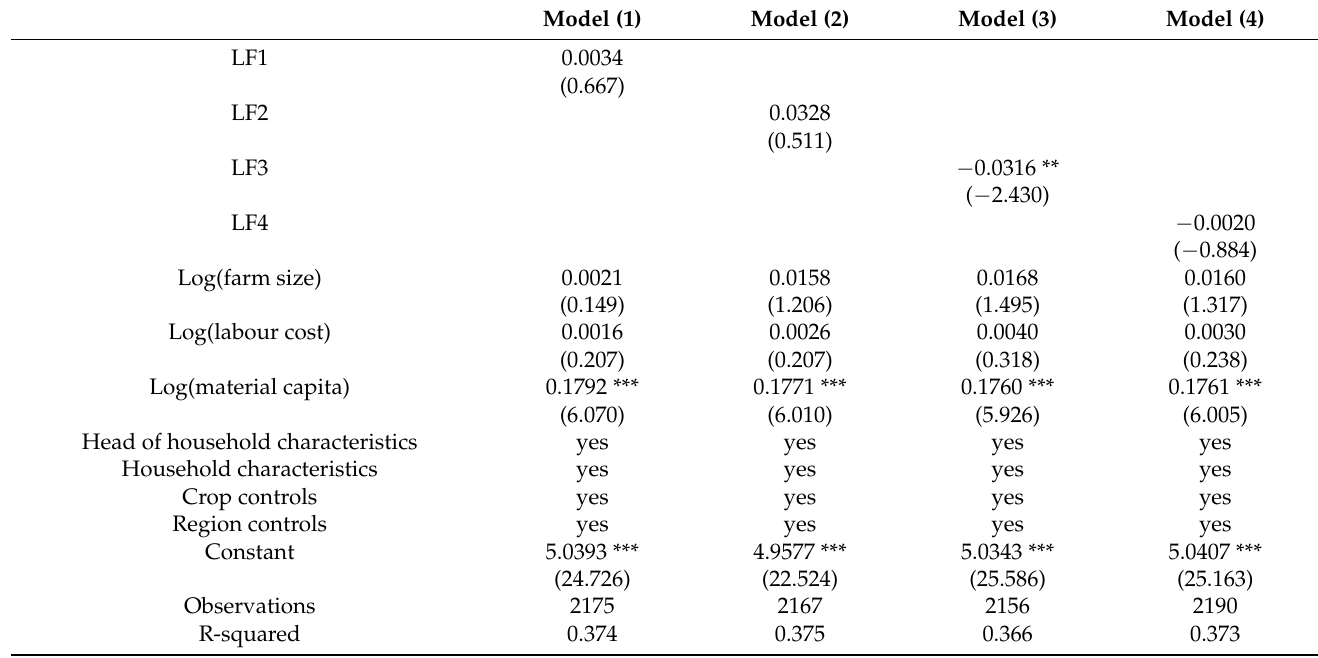
Table 7. Analysis of the effect of LF on yield.